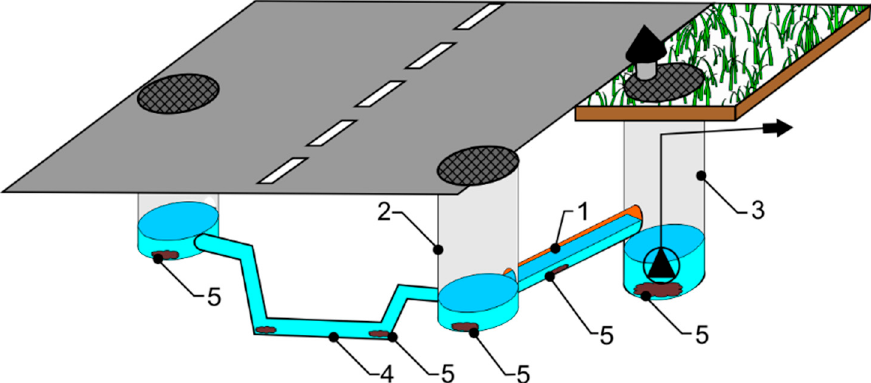
Figure 1. Accumulation of sewage in or at: 1—conduits, 2—sewer manholes, 3—sewage pumping stations, 4—syphon transitions, 5—sewage